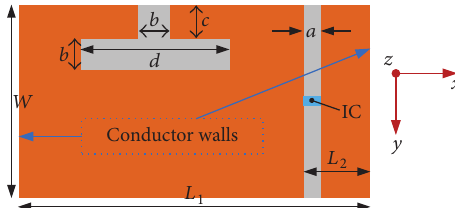
Figure 1: Structural diagram of the slotted patch antenna. Dimen- sions of the antenna in (mm): 𝐿 1 : 64.4, 𝐿 2 : 13.6, 𝑊 : 33.5, 𝑎 : 2, 𝑏 : 5, 𝑐 : 4.75, 𝑑 :